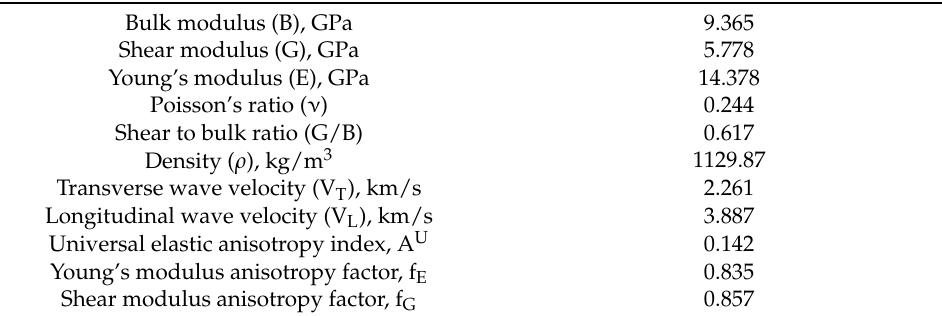
Table 3. Properties of CO 2 -NH sH gas hydrate at 0 K and 0